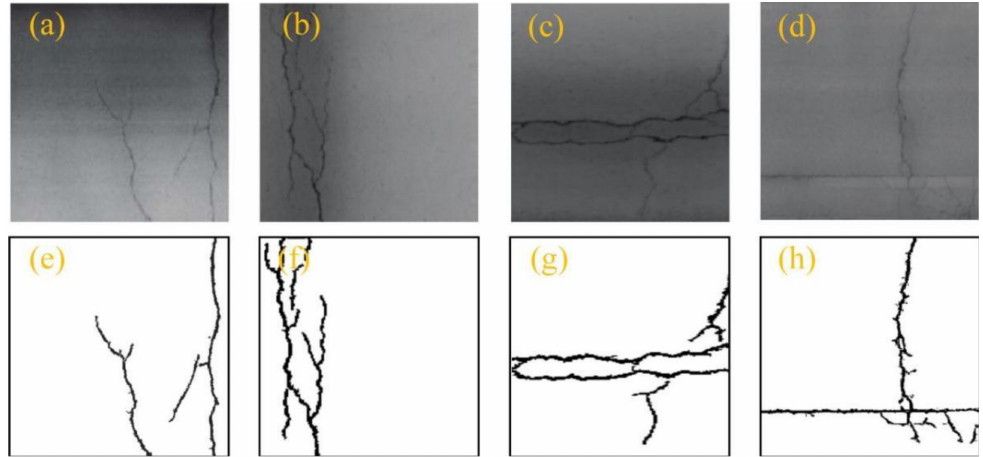
Figure 13. Segmentation results of simple concrete mesh cracks. ( a – d ) are the original images, ( e – h ) are the segmentation results of cracks.